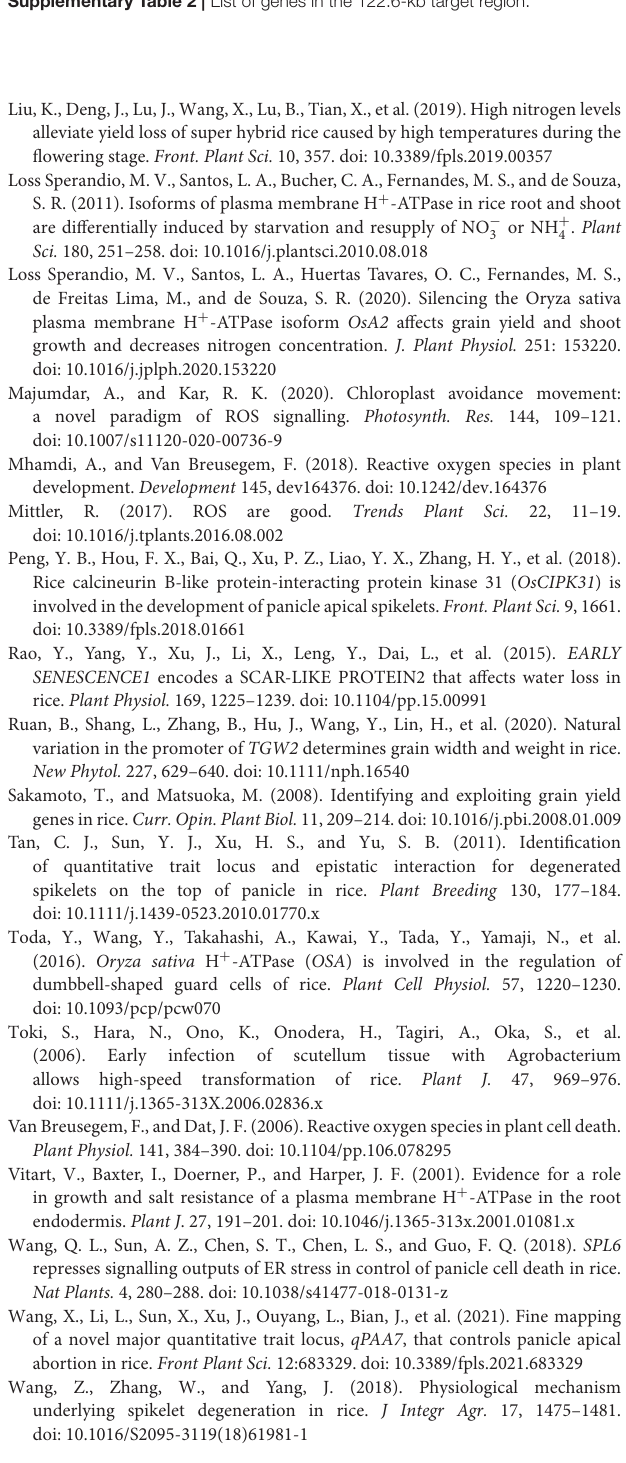
Supplementary Figure 5 | Relative expression levels of LMPA in the WT and lmpa grown at 30 and 20 ◦ C, respectively. Error bars represent standard deviation (SD) ( n = 3); ∗∗ Significant difference at p < 0.01 compared with the WT by Student’s t -test. Supplementary Figure 6 | Disruption of LMPA decreases salt tolerance in rice seedlings. (A–C) Phenotype of WT and lmpa mutant treated by salt stress for 7